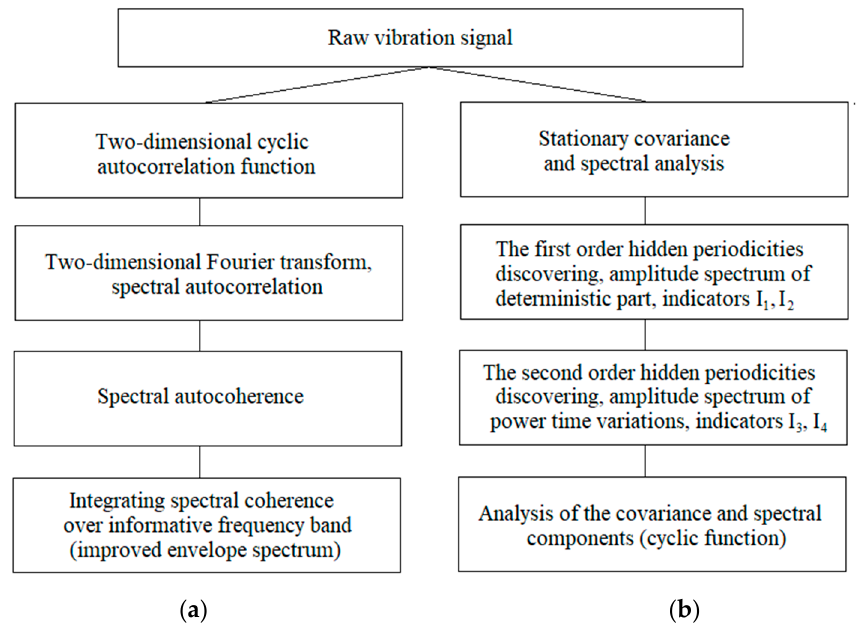
Figure 21. The main stages of the cyclostationary ( a ) and PCRP ( b ) analysis. The cyclostationary analysis involves the calculation of the cyclic auto-correlation function, depending on time and lag, and its two-dimensional Fourier transforms, which includes the search for correlated harmonics, the calculation of coherence functions, and